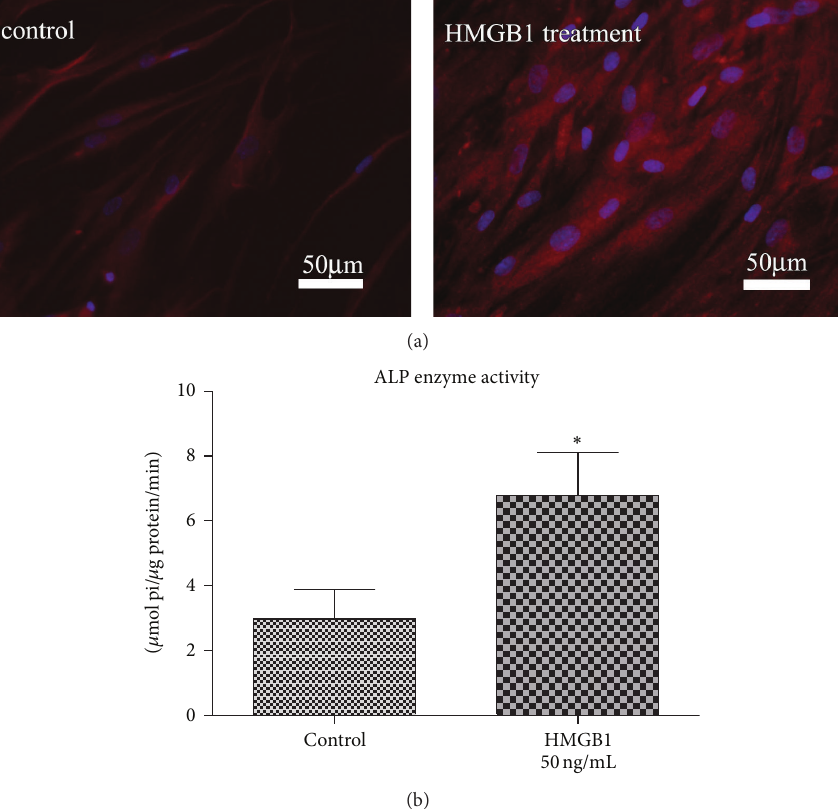
Figure 4: HMGB1 increases ALP protein expression. In addition to the transcriptional level, alkaline phosphatase specific activity was also enhanced at the protein level as visualized by immunofluorescent staining of hPDL cells (a). The visual impression was further confirmed and quantified by biochemical assay (b). Data represent the mean ± SD for six independent cultures. ∗ 𝑃 < 0.05 , experimental group versus untreated